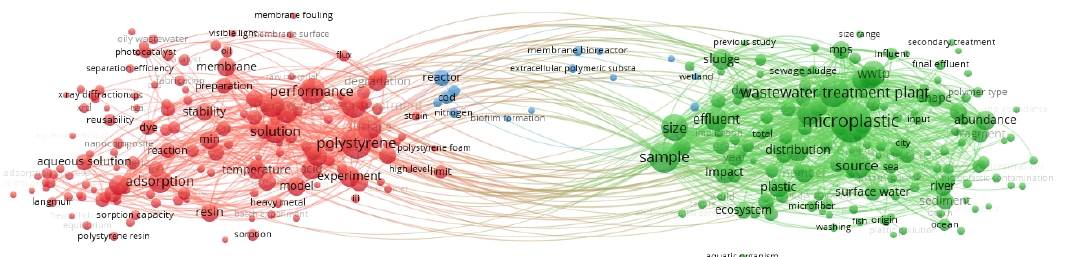
Figure 4. Term-occurrence analysis of data derived from the query Q2. An interactive visualization of the map is available at https://bit.ly/3xVikiF (The installation of Java 1.8.0 is needed before copying the link on the browser (the same is required for all the other links). Accessed date: 30 May 2021.